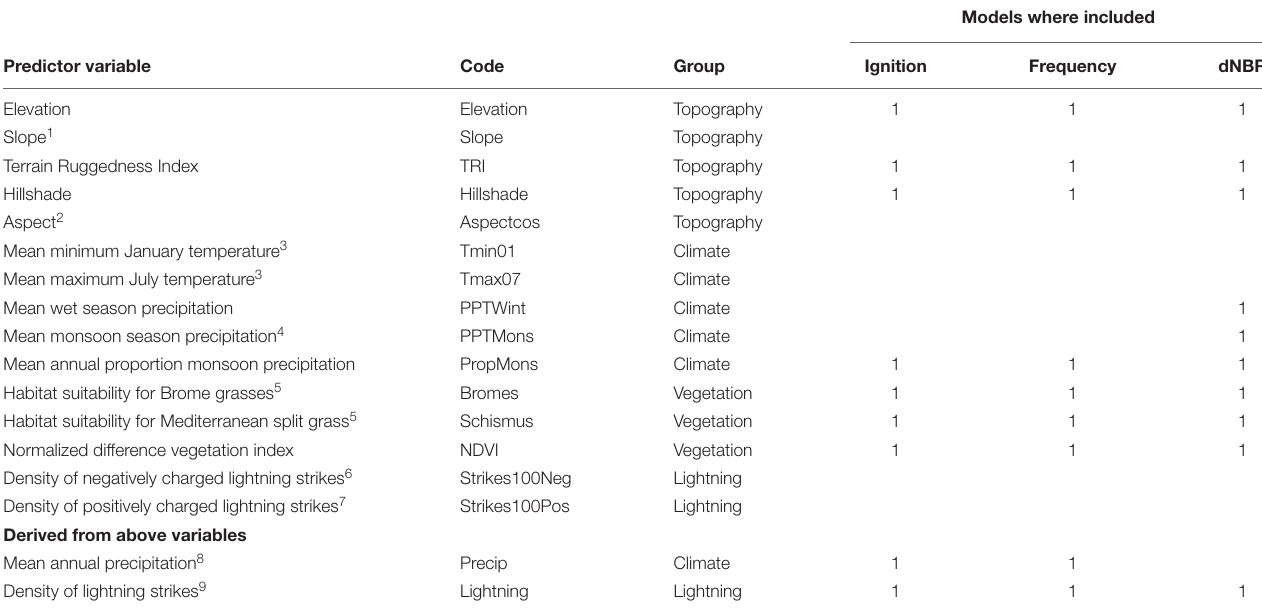
TABLE 1 | Potential predictor variables in models of probability of ignition, fire frequency, and burn severity (difference normalized burn ratio; dNBR) in the Mojave Desert of North America.